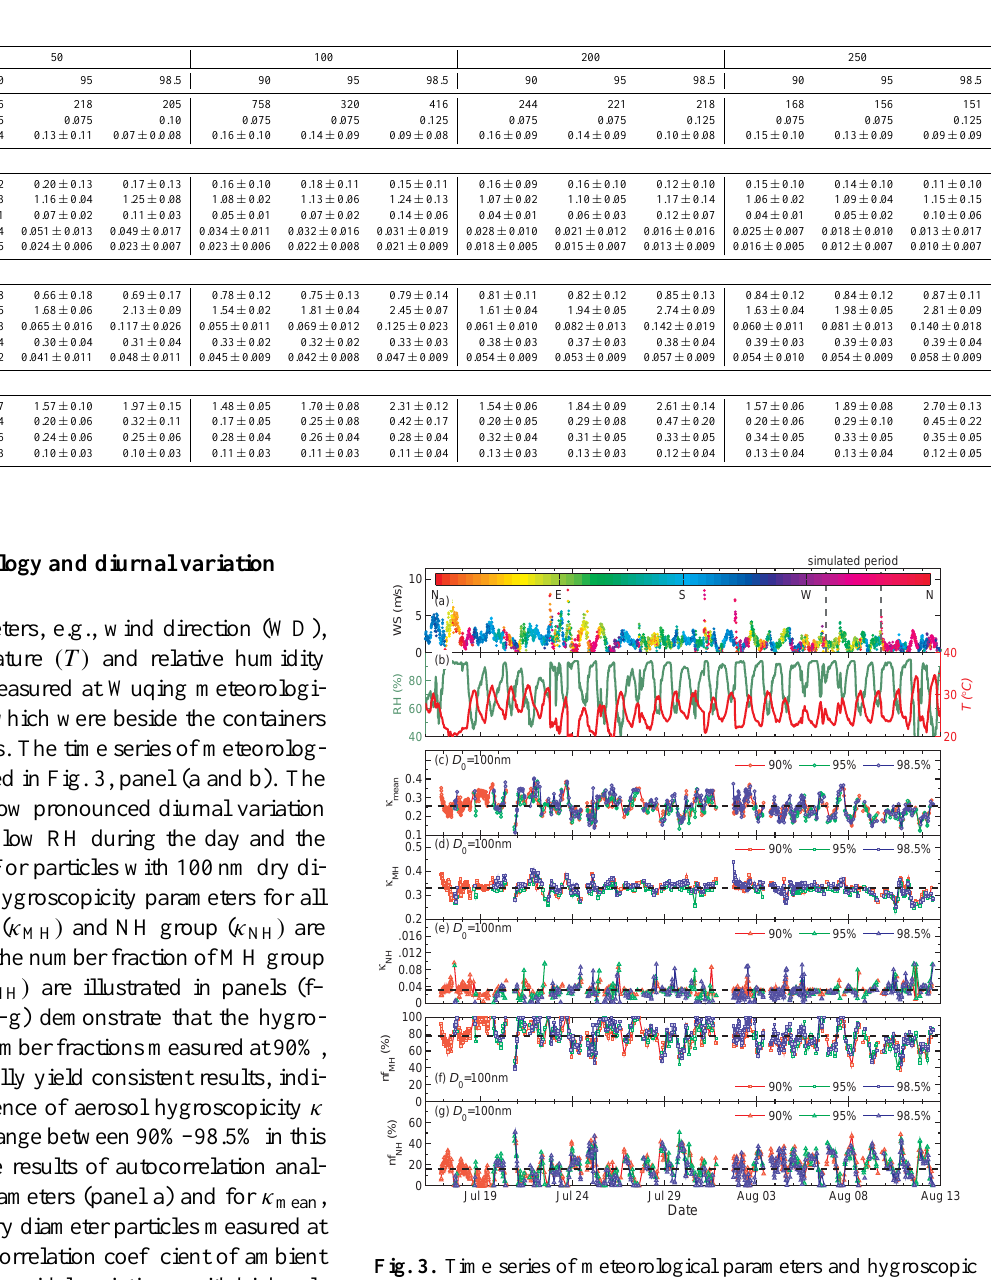
Table 1. Summary of the HH-TDMA measurements of hygroscopic growth at 90%, 95% and 98.5% RH during HaChi summer campaign (mean value ± 1 standard deviation).